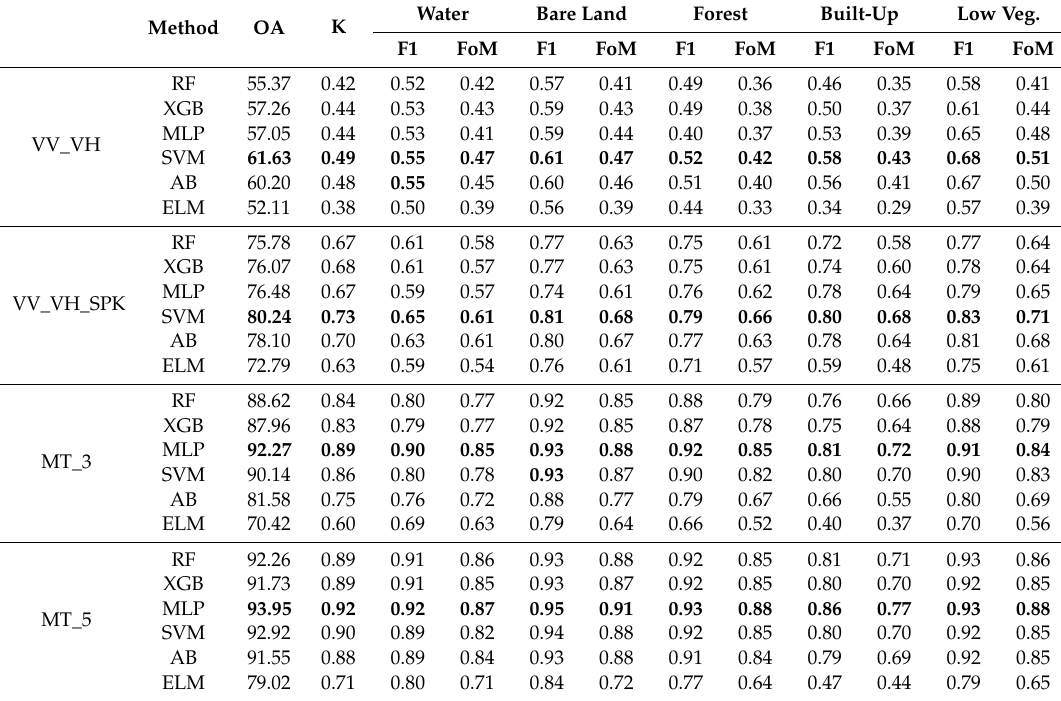
Table 3. The mean values of overall accuracy (OA), K, the F1 measure (F1), and the Figure of Merit (FoM) in di ff erent classification scenarios using S1 imagery with six machine learning classifiers (the bold values indicate the most accurate performance achieved for each classification scenario).